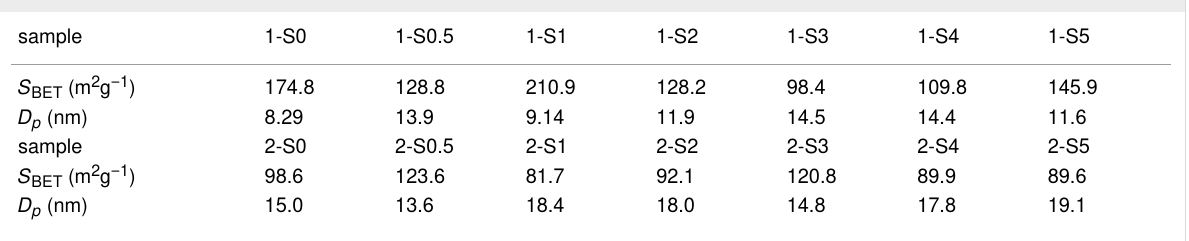
Table 6: Textural parameters of all samples.